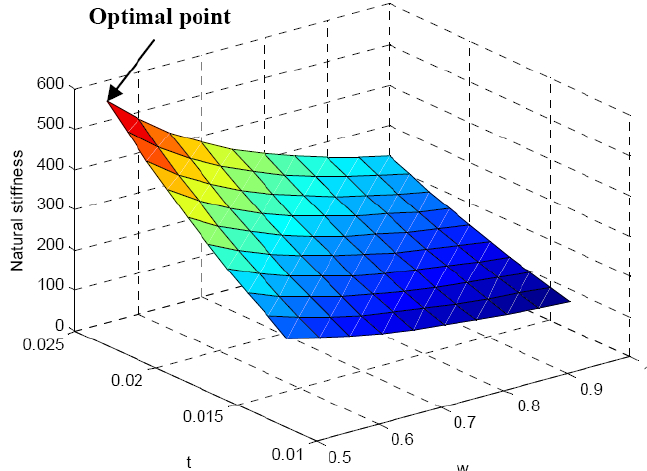
Figure 9. Natural frequency.